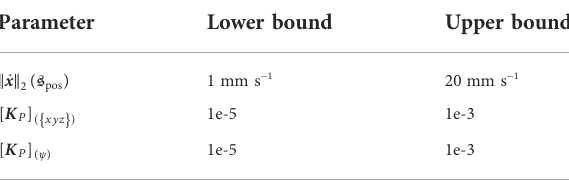
TABLE 1 This table summarizes the unknown controller parameters for the unscrewing skill given the presented controller from Section 4.1.